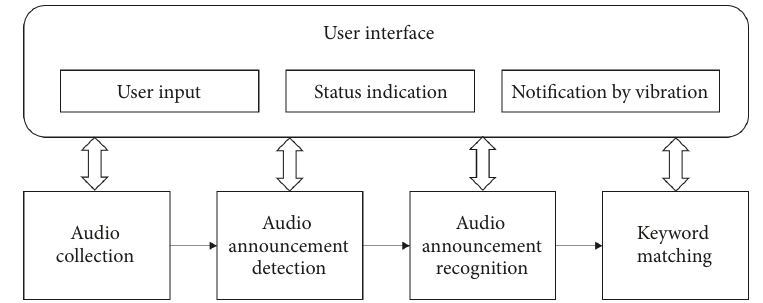
Figure 1: Framework of the proposed